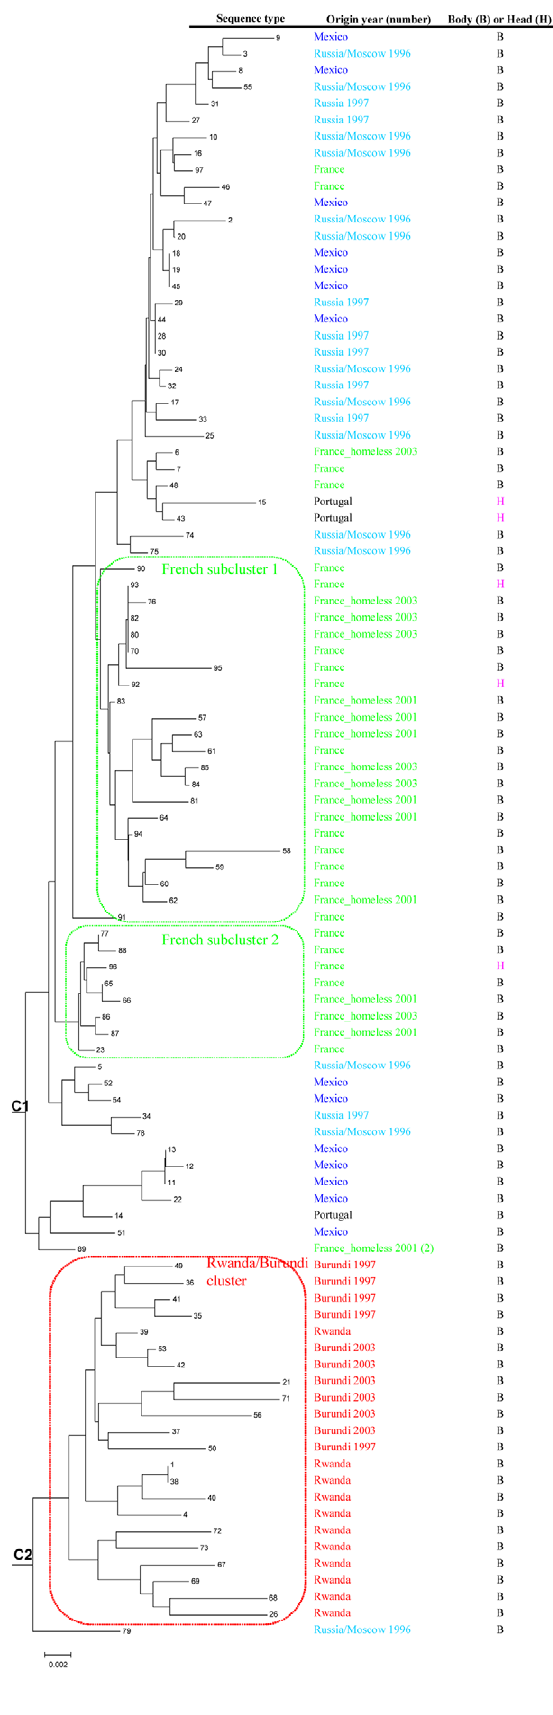
Figure 1. Phylogenetic organization of 97 human lice based on concatenation of four nuclear intergenic spacers, PM1, PM2, S2, and S5, using the neighbor-joining method.